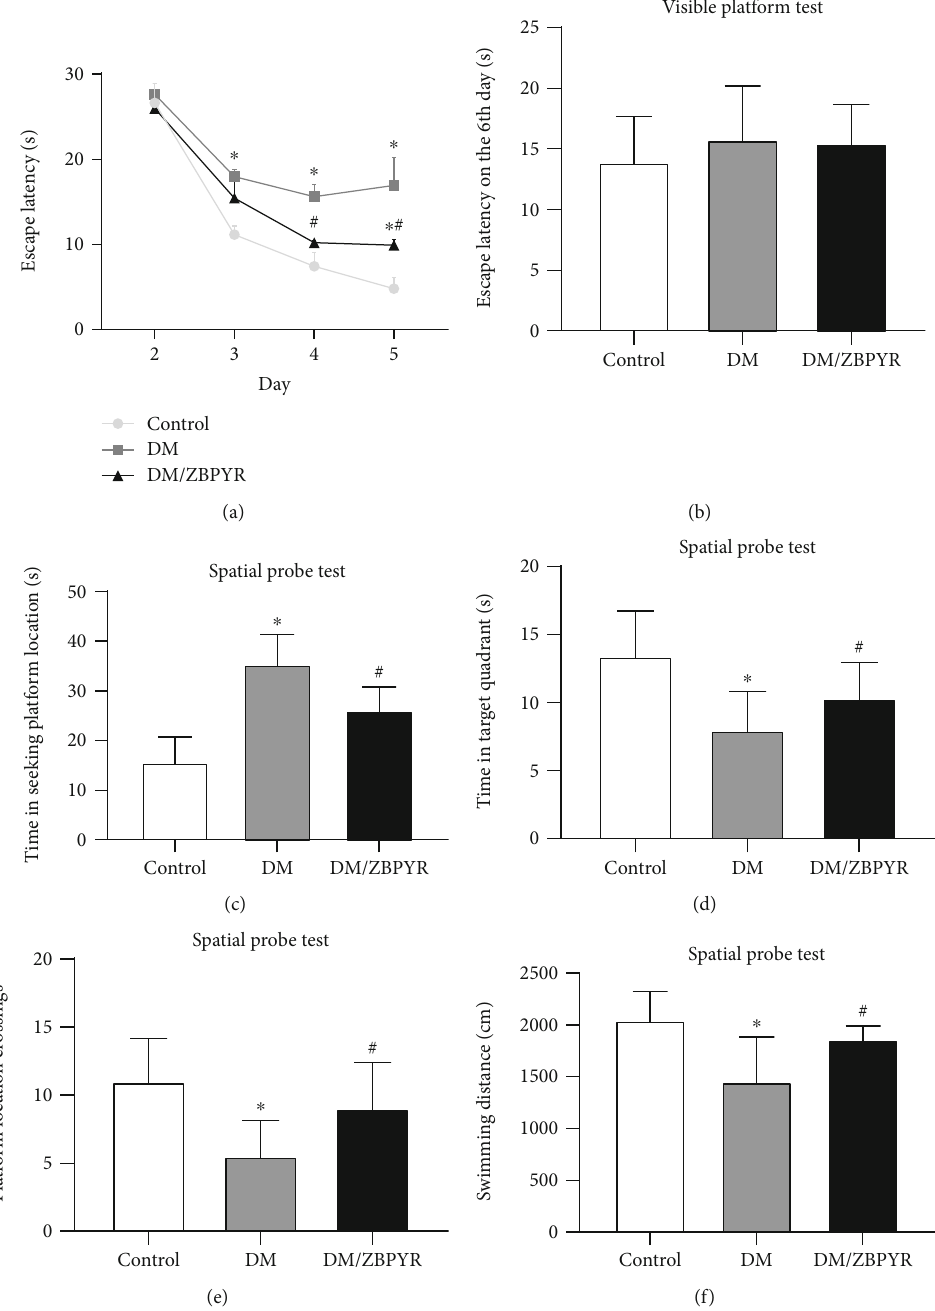
Figure 2: E ff ects of ZBPYR on DACD mice in Morris water maze test. (a) escape latency, (b) escape latency in the visible platform test, (c) time in searching original platforms, (d) time in target quadrant, (e and f) platform location crossings and swimming distance in spatial probe test. Values are means ± S : D : from 4 mice in each group. ∗ p < 0 : 05 compared to control; # p < 0 : 05 compared to